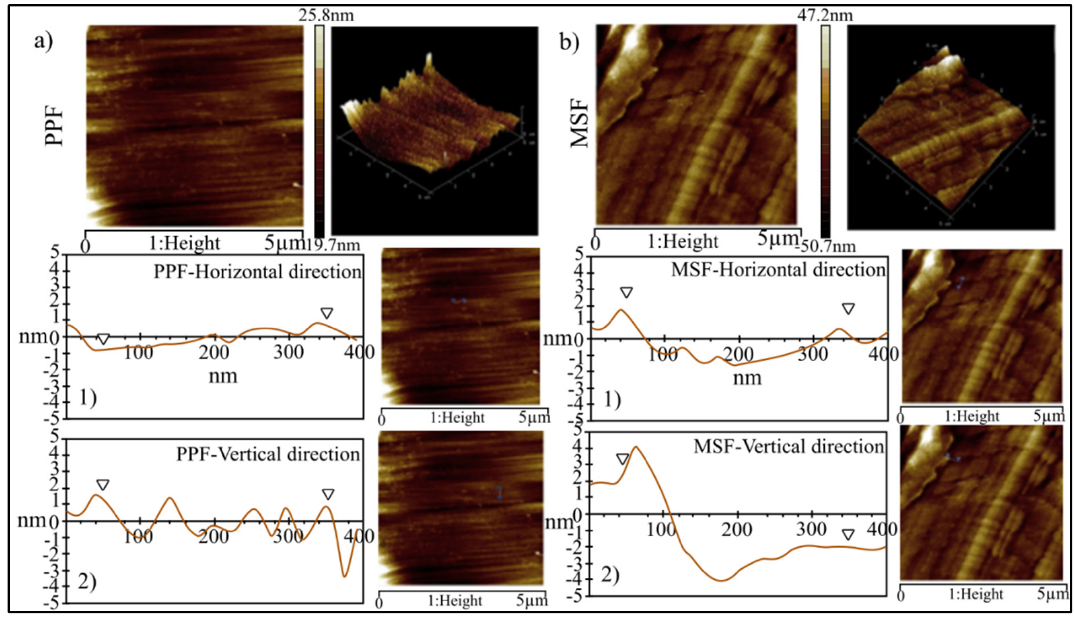
Figure 7. PPF ( a ) and MSF ( b ) surface observation a nanometric scale using AFM [21].